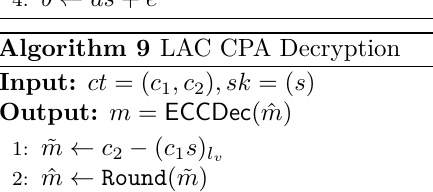
Algorithm 9 LAC CPA Decryption